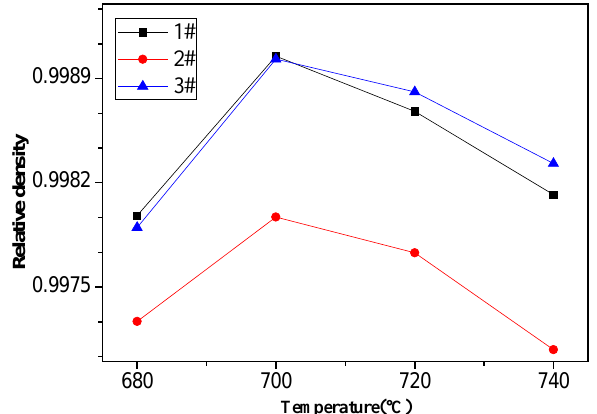
Figure 3. The density results of vacuum counter-pressure casting alloy samples under different pouring temperature.